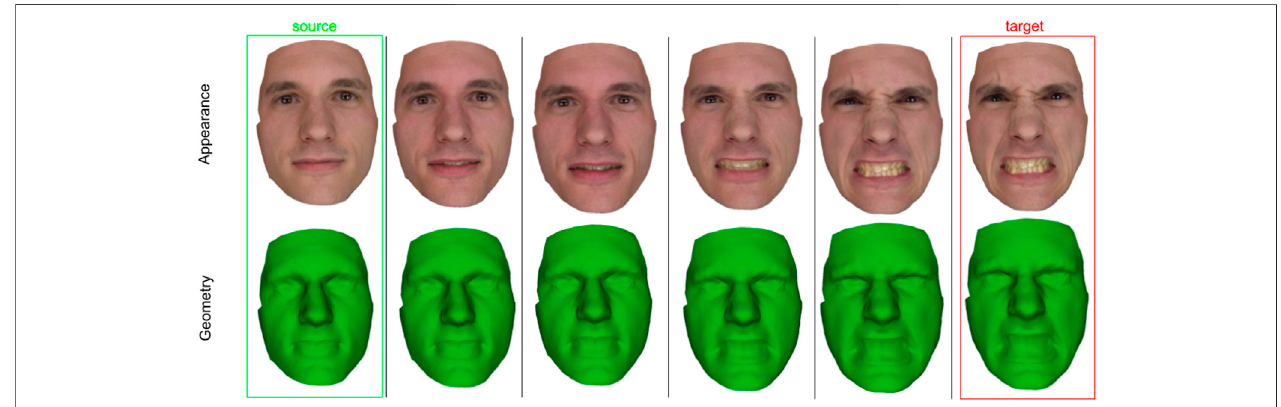
FIGURE 11 | Latent space interpolation, two frames with distinct 3D motion landmarks are selected, on the left surrounded with a green box is the source, on the right surrounded with a red box is the target, in between is the interpolated results for shape and appearance.